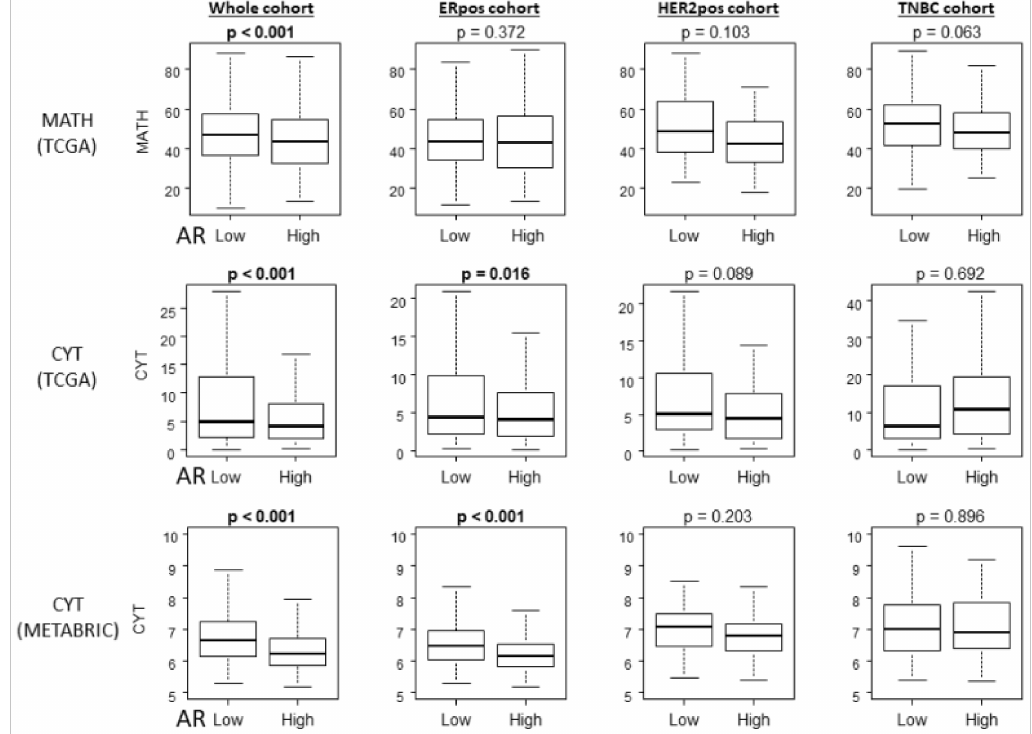
Figure 5. Tumor heterogeneity and cytolytic activity score in AR high BC is lower than that in AR low ER-positive BC.